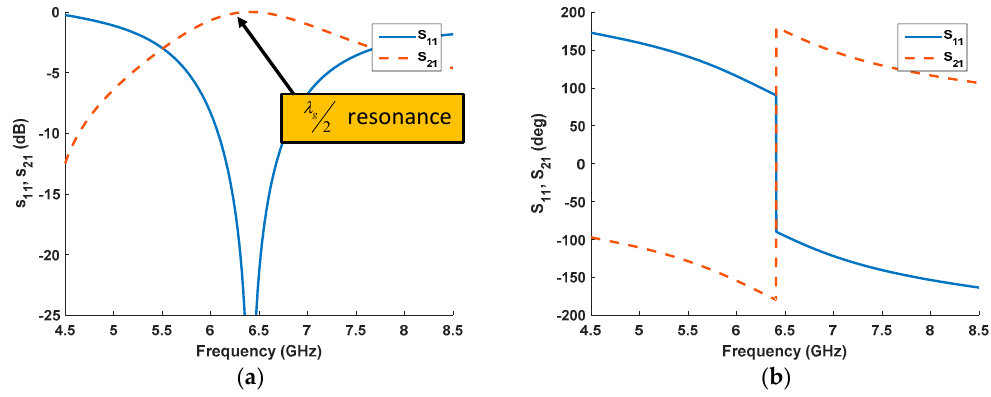
Figure 3 . Transmission and reflection coefficient: ( a ) amplitude; ( b ) phase of a rectangular sample of 8 mm thickness with ε r = 9 − j0, µ r = 1 − j0.